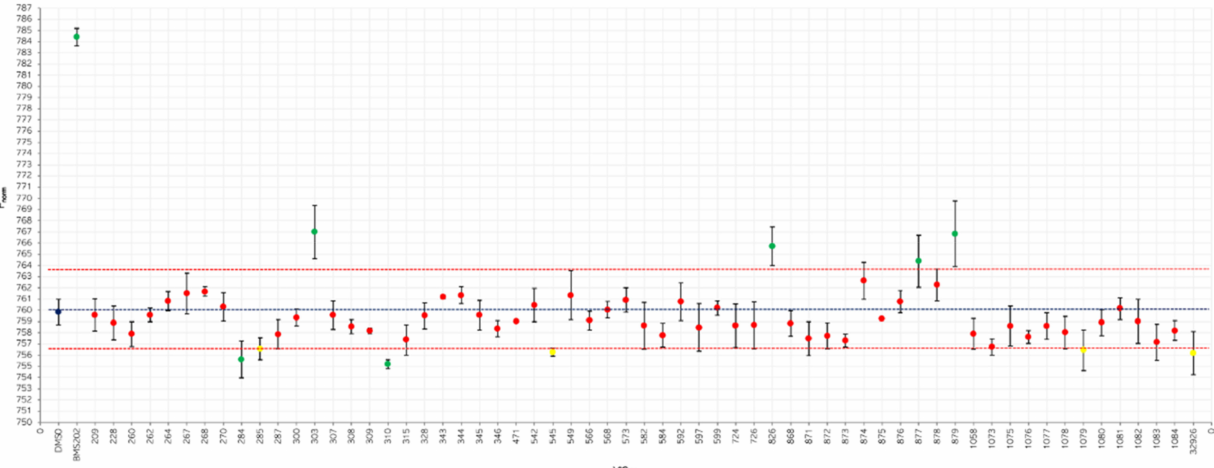
Figure 3. Results of single-point binding assays against NT650/PD-L1 of 60 virtual hits (Table S1, supplementary material) as compared to vehicle (DMSO) and positive control (BMS-202, 5 ). Green and red dots indicate virtual hits compliant and non-compliant to the definition criterion of binders, respectively; yellow dots indicate compounds at the borderline of the definition